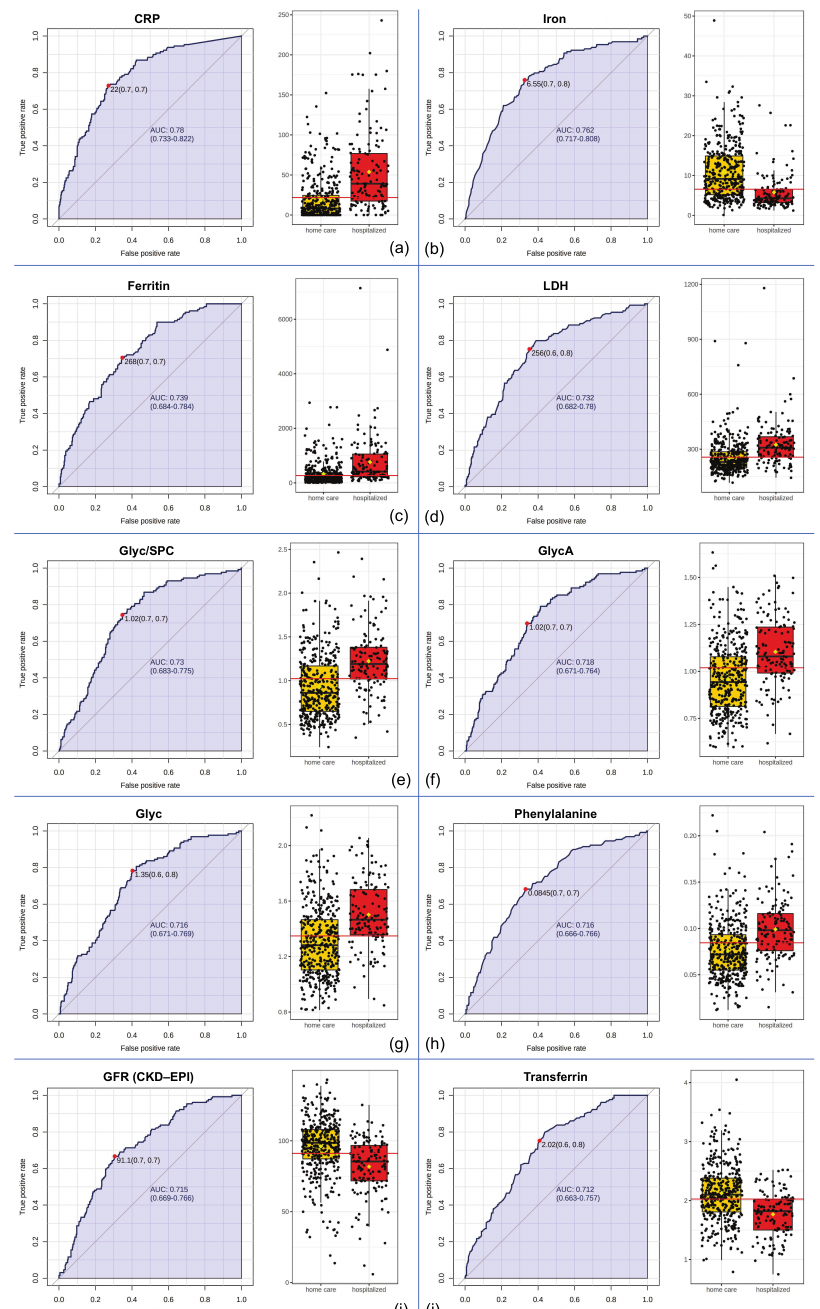
Figure 6. Top ten parameters established from univariate biomarker analysis for hospitalization. For each biomarker, a comparison of the individual values of the respective parameters is shown on the right, and receiver operating characteristic (ROC) curves are found on the left. ROC curves illustrate the number of true positives and false positives for each possible threshold, and the trade-off of these values is quantified in the area under the curve (AUC). An AUC of 0.5 implies a random distribution with no association of the parameter with, in this case, hospitalization, whereas an AUC of 1 implies a perfect predictive model. The parameters are sorted by AUC, with the top parameter can be found under ( a ) and the AUC decreases steadily until ( j ). The red dots on the curves indicate the ideal classification thresholds. For example, an iron threshold of 6.55 (subfigure ( b )) can correctly identify 70% of the hospitalized COVID-19 patients in our cohort and can correctly classify 80% of the patients who were not admitted to the